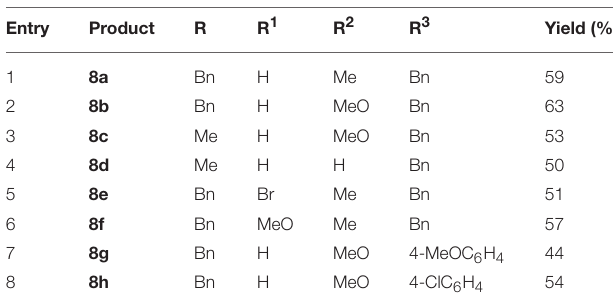
TABLE 4 | Synthesis of amides 8 a .